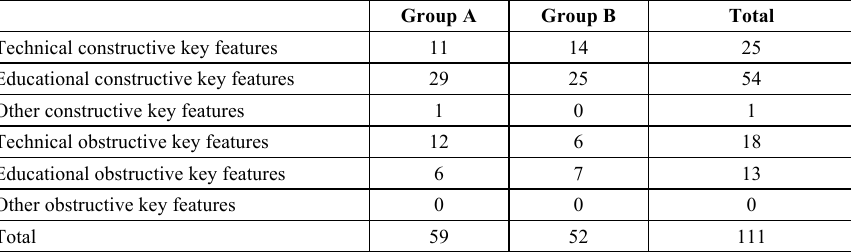
Table 5. Number of technical and educational key